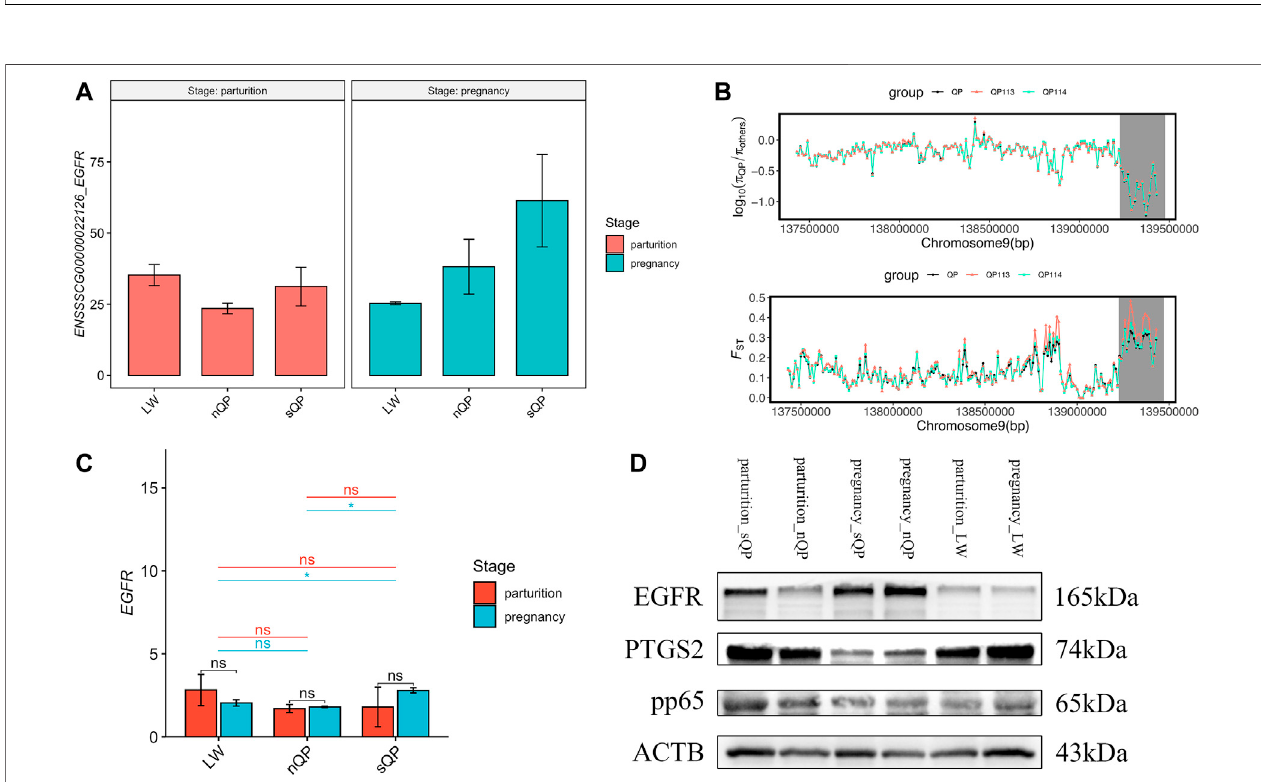
FIGURE 5 | EGFR is associated with short gestation length. (A) EGFR expression in the RNA-seq results. (B) Selective sweep analyses of EGFR , including π and F ST . (C) EGFR real-time PCR results of the placenta in QP and LW pigs. (D) Western blot results of the placenta in QP and LW pigs.